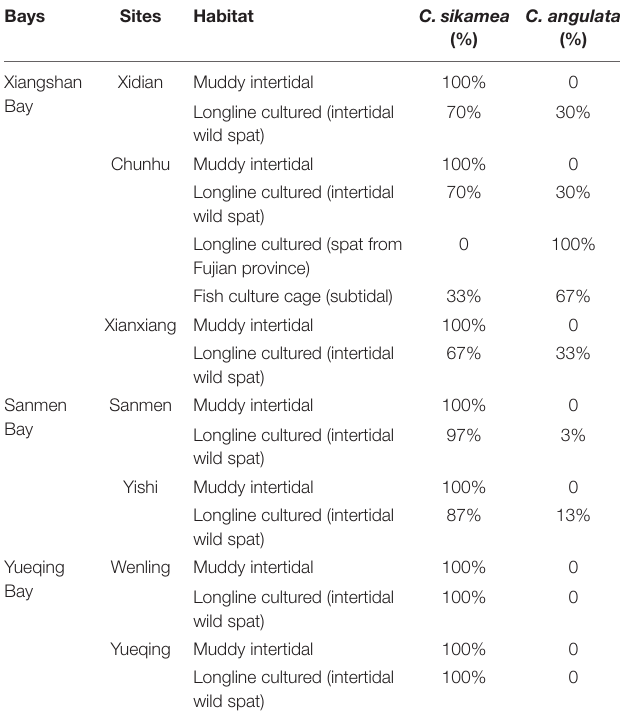
TABLE 2 | Oyster species distribution and proportion of different sampling